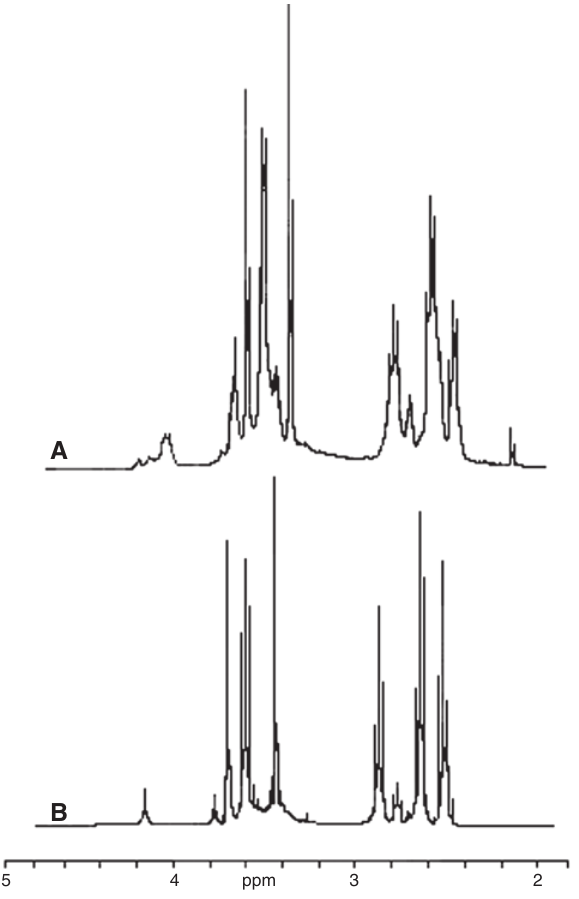
Figure 2 1 H NMR spectra of (A) G2 HPAE and (B) G3